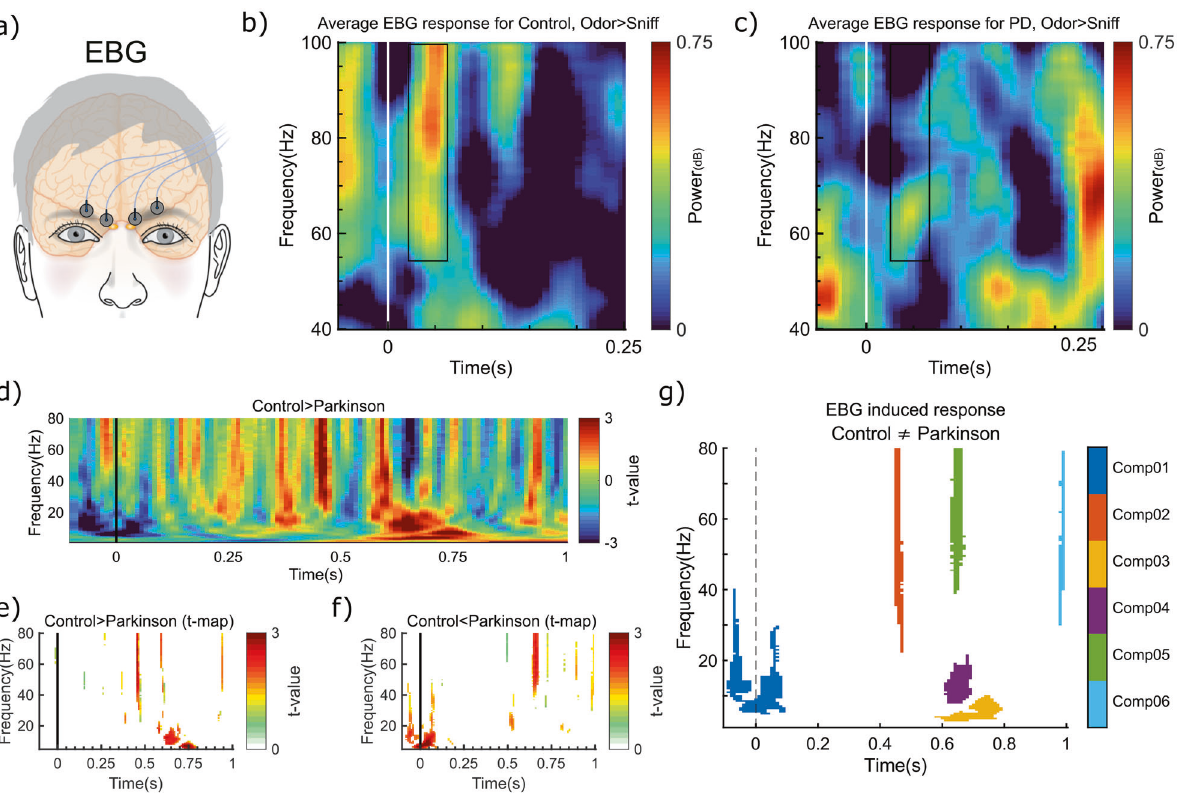
Fig. 1 EBG measure can dissociate PD from control. a Placement of EBG electrodes on the forehead. b Odor-induced EBG response in the healthy controls replicates earlier studies. Gamma synchronization appears brie fl y after the odor onset (indicated by the horizontal white line at Time 0) for Controls. c No gamma synchronization was found for PDs in the same time period (EBG area of interest was marked with a black rectangle). Warmer colors indicate synchronization whereas cooler colors indicate desynchronization compared to Sniff (clean air). d T-map derived from 1000 Monte Carlo permutation tests. Early and late differences between Control and PD are statistically meaningful in theta, beta, and gamma band. e Threshold t-maps indicating areas with p < 0.05 where power is more for Control compared with PD. f Threshold t-maps indicating areas with p < 0.05 where power is less for Control compared with PD. Warmer colors in the t-maps represent higher t - values. g Clusters of signi fi cance ( p < 0.05, cluster size > 100) differentiated EBG components that dissociate Control from PD. Speci fi cally, we isolated six different components in the gamma, beta, and theta bands during the early and late time points. Each component is illustrated with a speci fi c color and color labels can be found in the color bar on the right side of the